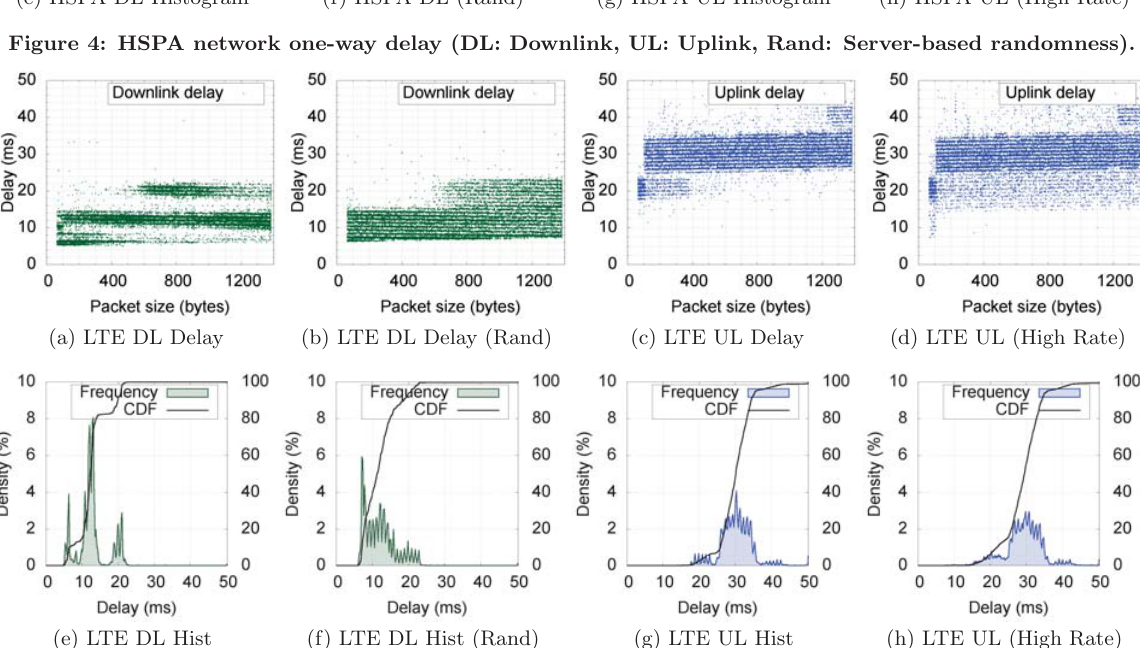
Figure 5: LTE network one-way delay (DL: Downlink, UL: Uplink, Rand: Server-based randomness) deterministic HSPA uplink